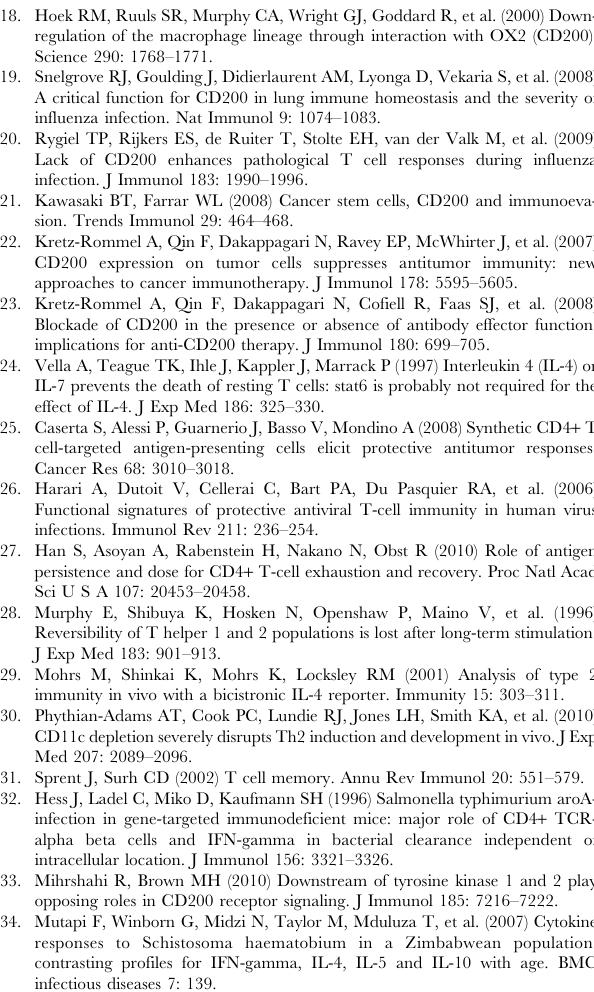
Figure S9 Expression of CD200R in human CD45RA – CD4 + ab TCR + cells and isotype controls for intracellular stains. A. Dot plots show expression of CD45RA and CD200R